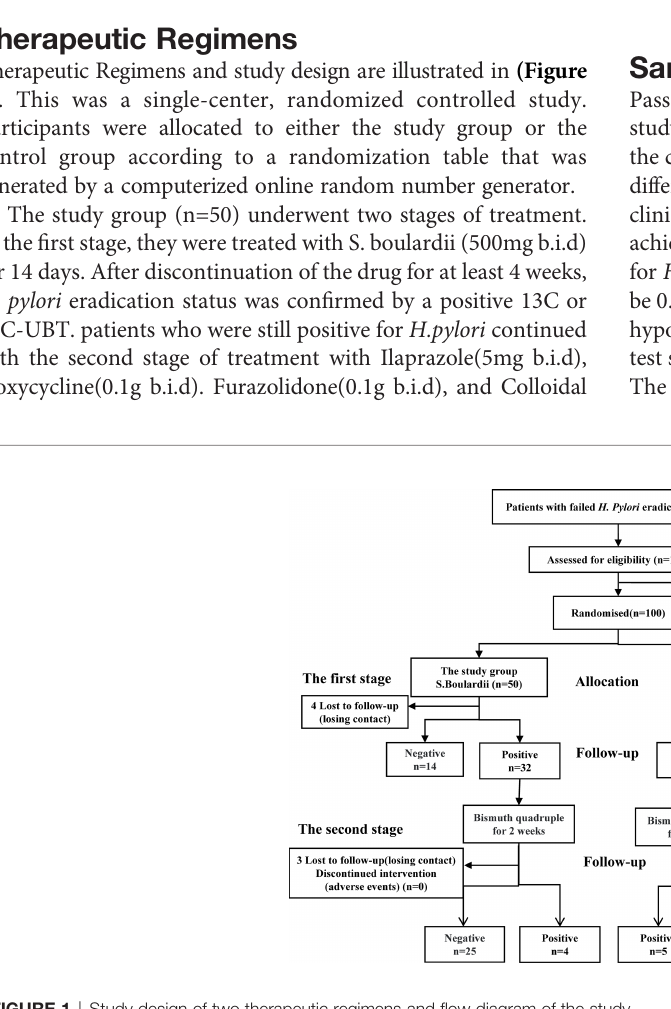
FIGURE 1 | Study design of two therapeutic regimens and fl ow diagram of the